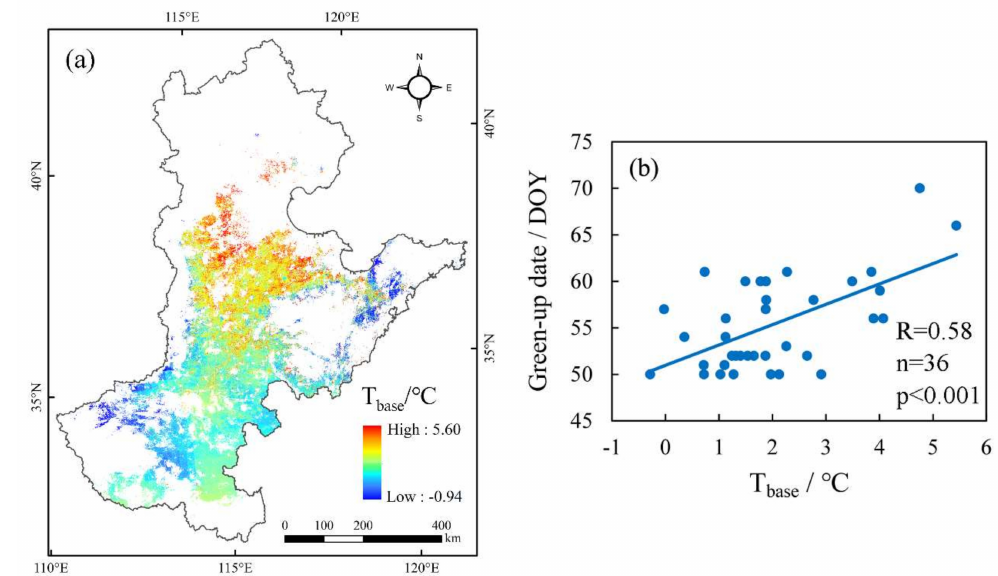
Figure 3. The spatial distribution of the optimal T base in NCP ( a ) and the scatter plot between the optimal T base and the average of green-up dates observed at the phenology observation stations during 2017–2019 ( b ). The optimal T base is defined as the average value of daily mean temperature during the month before the green-up date. DOY: Julian day of